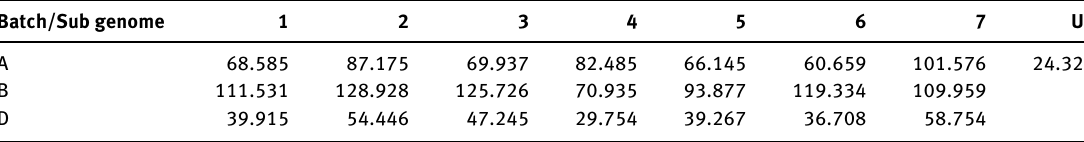
Table 2: Marker numbers for the test data set over the chromosomes.